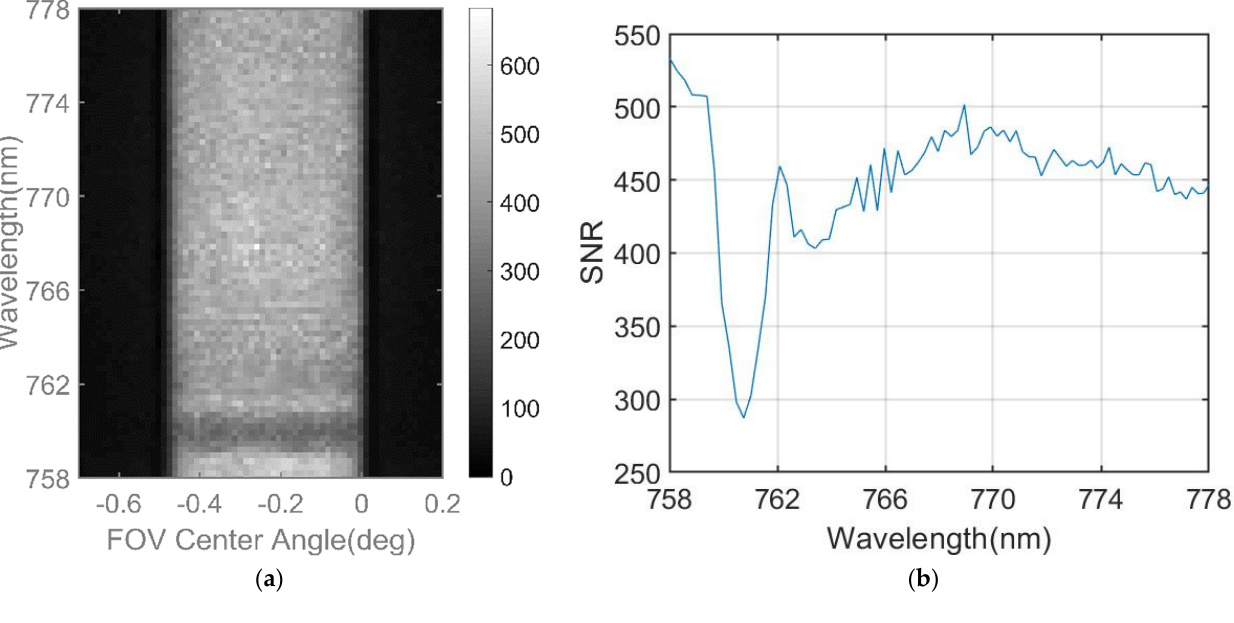
Figure 20. SNR of the 100 frames of data collected at 15:41 on 9 October ( a ) and the mean SNR of the full imaging area ( b ).